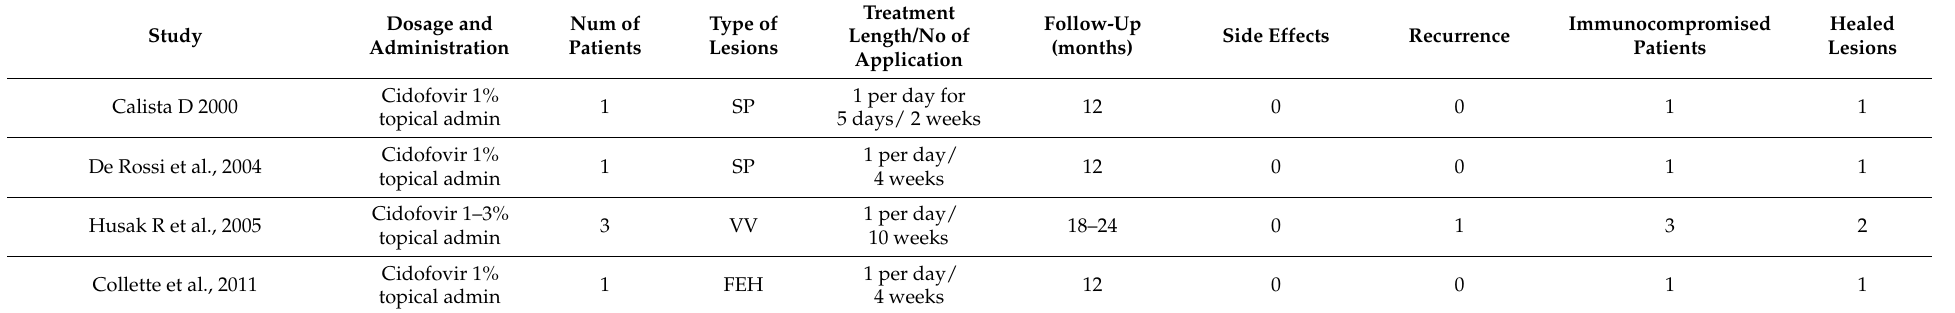
Table 3. Cidofovir studies.